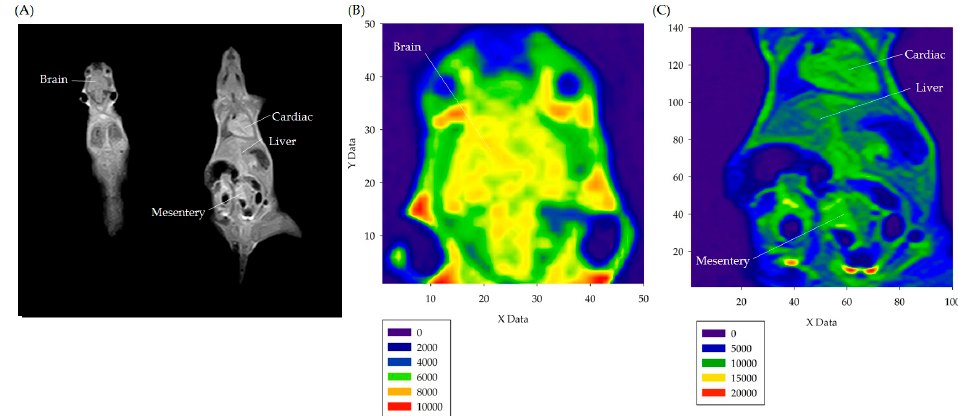
Figure 4. ( A ) The DICOM 3.0 image of a mouse under T1W pulse sequence. ( B ) The visualized grayscale imaging of the mouse brain. ( C ) The visualized grayscale imaging of the mouse heart, liver, and mesentery.